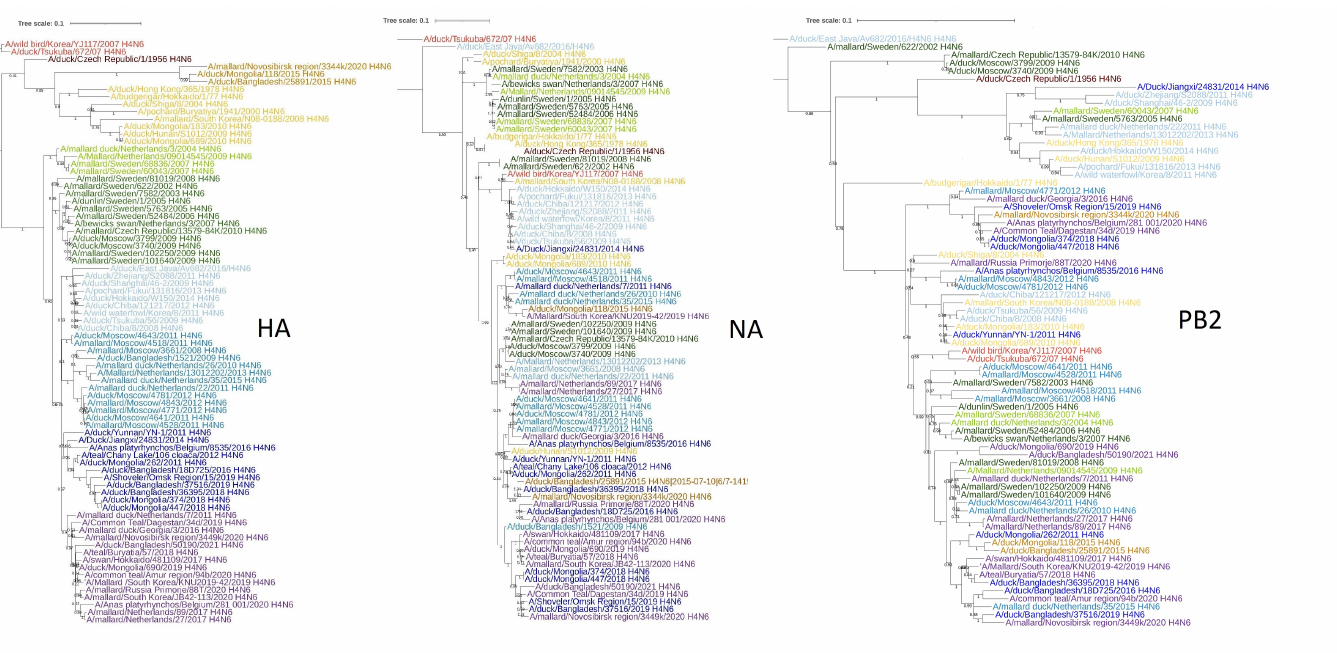
Figure 2. Phylogenetic tree of the HA, NA, and PB2 genes of Eurasian H4N6 viruses. The viruses are painted with the same color on different trees. Scalable versions of the trees are given in Supplementary Materials, Figures